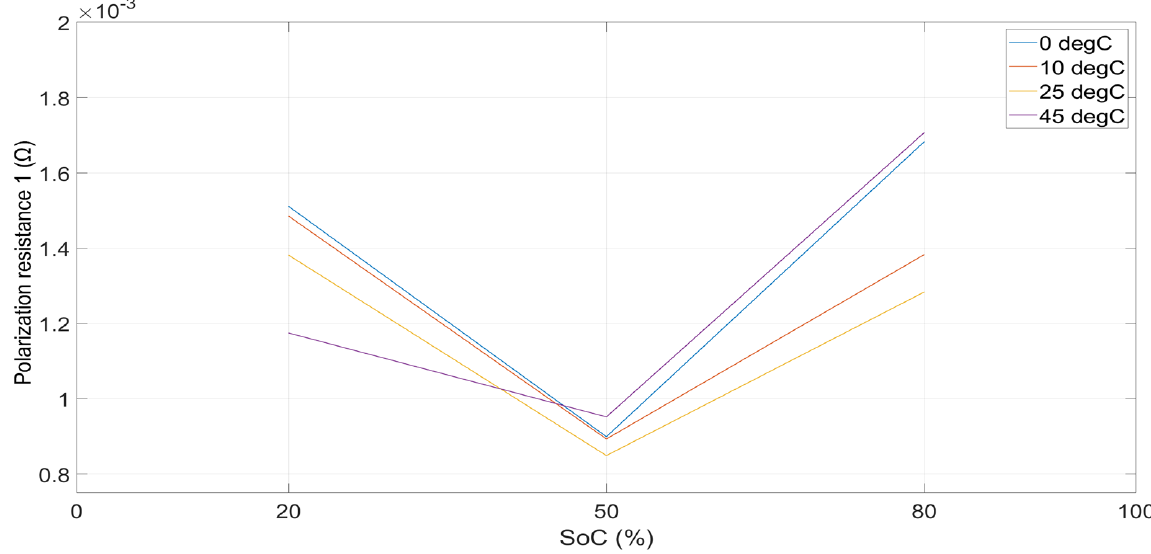
Figure 4. Ohmic resistance as a function of temperature and state of charge.